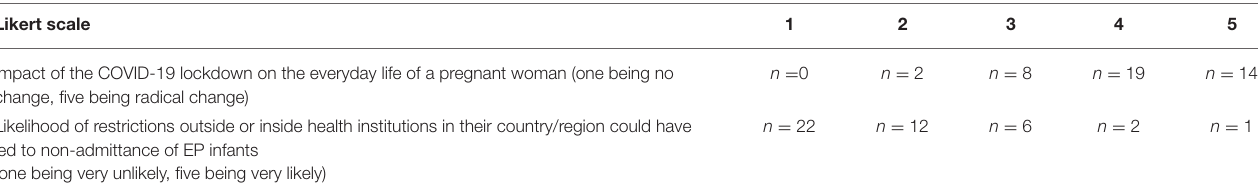
TABLE 4 | Reporting of exploratory outcome results. Likert scale